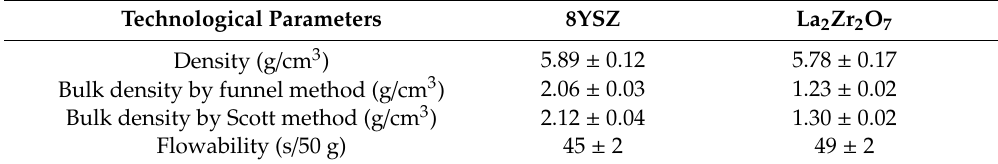
Figure 3. Phase composition of feedstock 8YSZ powder, ( a , b ) Kikuchi lines-EBSD method, ( c ) XRD di ff raction pattern. Table 2. Technological parameters of powders used for plasma spraying of thermal barrier coating (TBC)